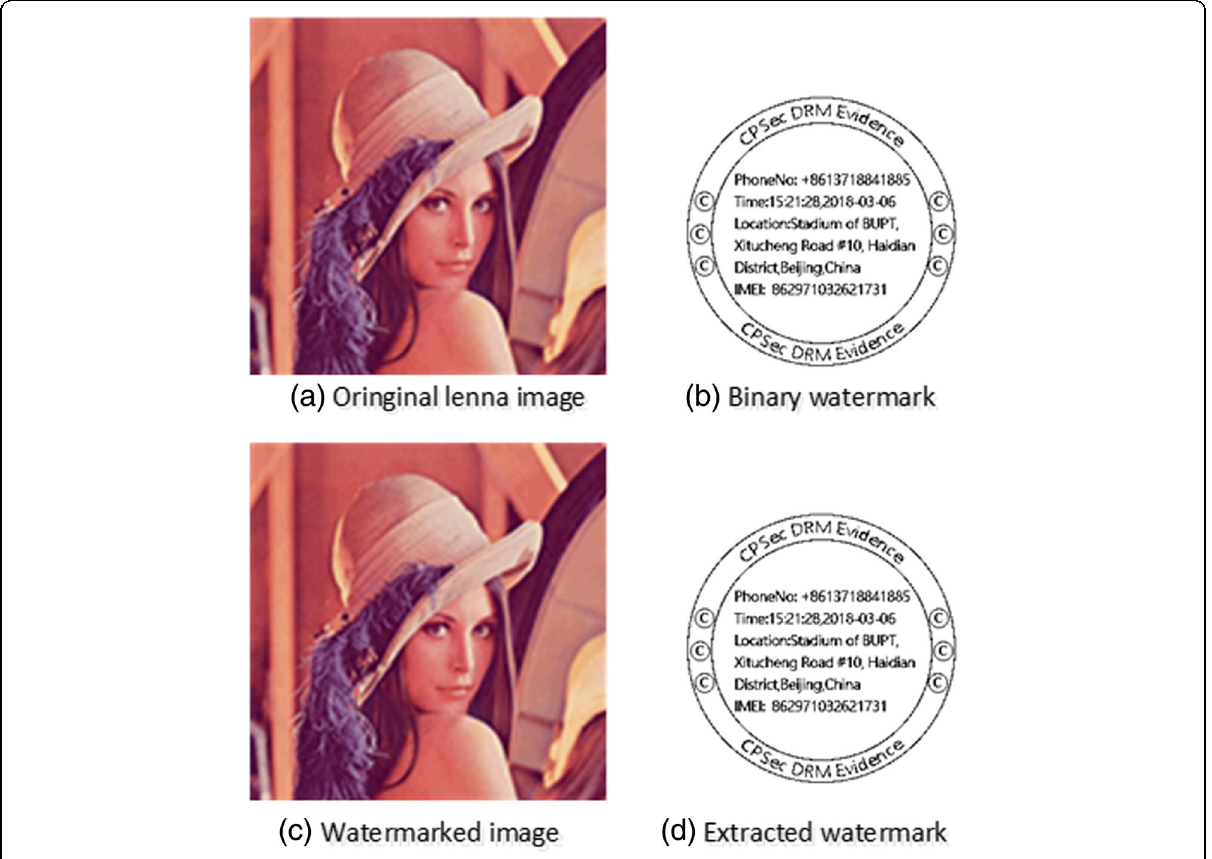
Fig. 9 Watermark embedding and extracting